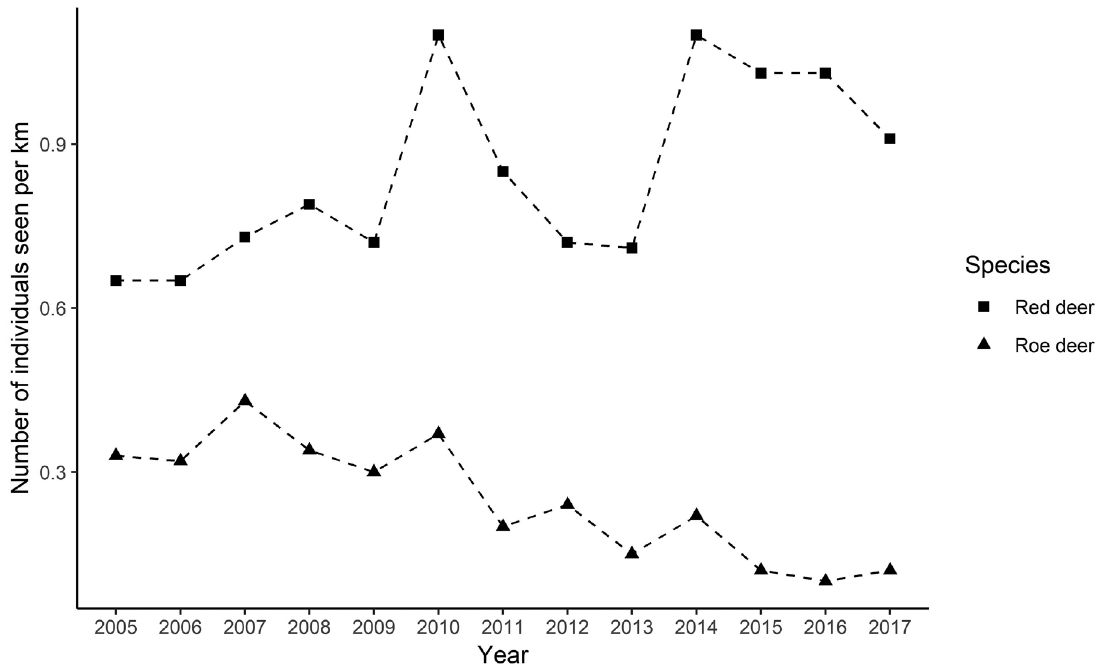
Figure 1 – Yearly dynamics of the mean number of roe deer (pedestrian kilometric index according to Vincent et al. 1991) and red deer (spotlight counts according to Garel et al. 2010) observed per kilometer in La Petite Pierre NHWR from 2005 to